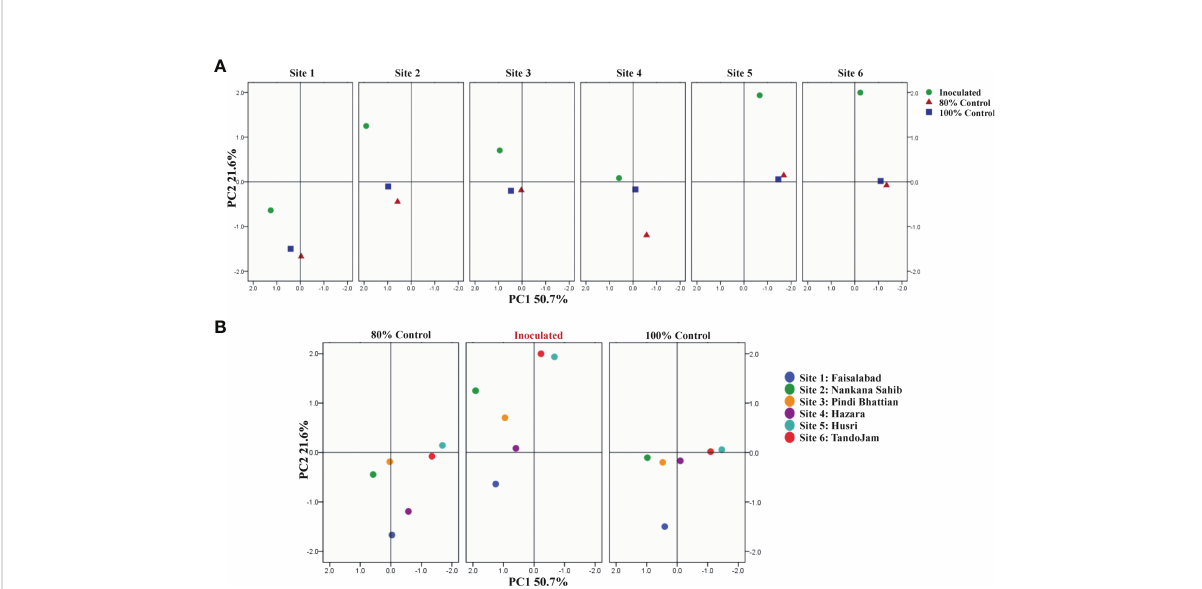
FIGURE 6 Principal component analysis (PCA) of wheat varieties inoculated with PSB and reduced application of DAP; treatment-wise (A) and location- wise analysis (B) . Treatments: inoculation of soil-speci fi c consortia and uninoculated controls. Site 1: Faisalabad, Site 2: Nankana Sahib, Site